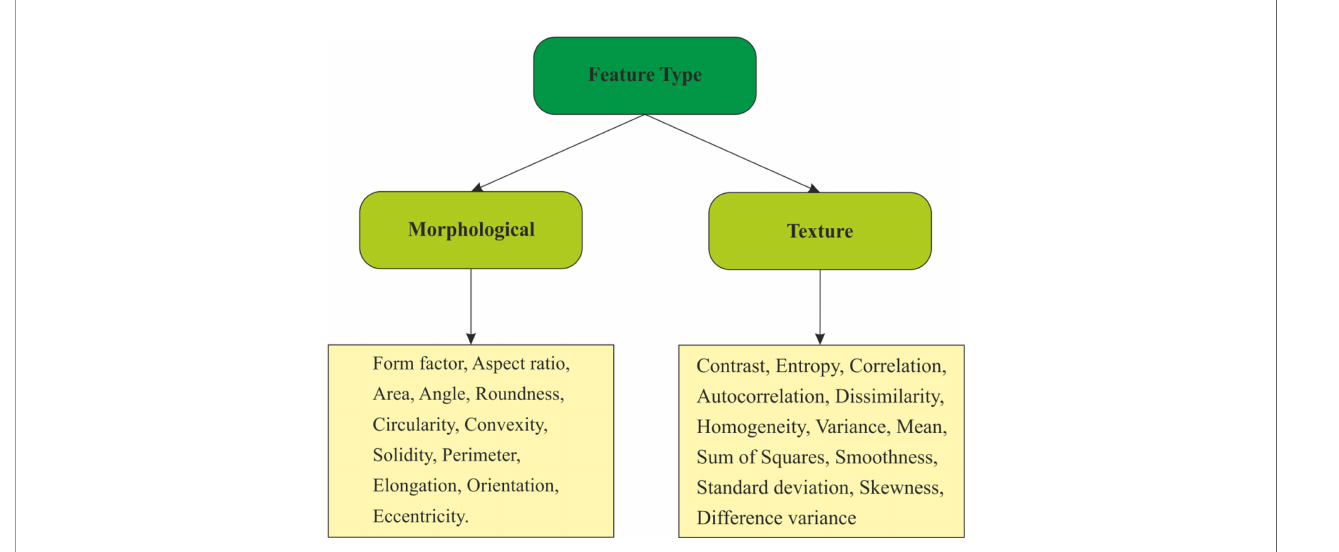
FIGURE 5 | Selected features for this proposed scheme.